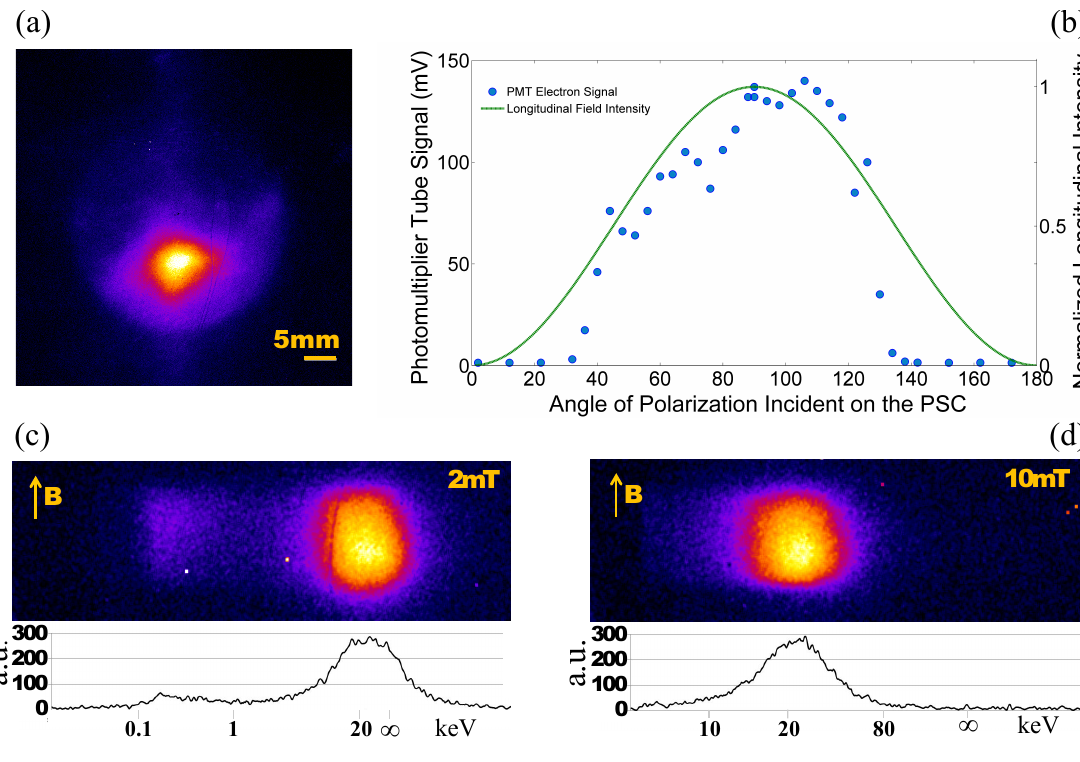
Experimental observation of direct longitudinal electron acceleration in tightly-focused RPLPs. ( a ) Electron beam profile averaged over 10 4 shots as observed by the camera (the circular shadow is the projected small aperture of the reflecting mirror); ( b ) Electron signal measurement from the photomultiplier tube while moving gradually from the TE mode ( 0 ◦ and 180 ◦ ) to the TM mode ( 90 ◦ ). The normalized longitudinal electric field 01 01 intensity is also indicated; ( c )–( d ) Electron spectrum measurement through the magnetic coil (average of 10 4 shots); ( c ) Signal with the magnetic coil residual field of 2mT; ( d ) Signal with a magnetic field of 10mT. Both measurements confirm the production of 23-keV electrons. Figure adapted from